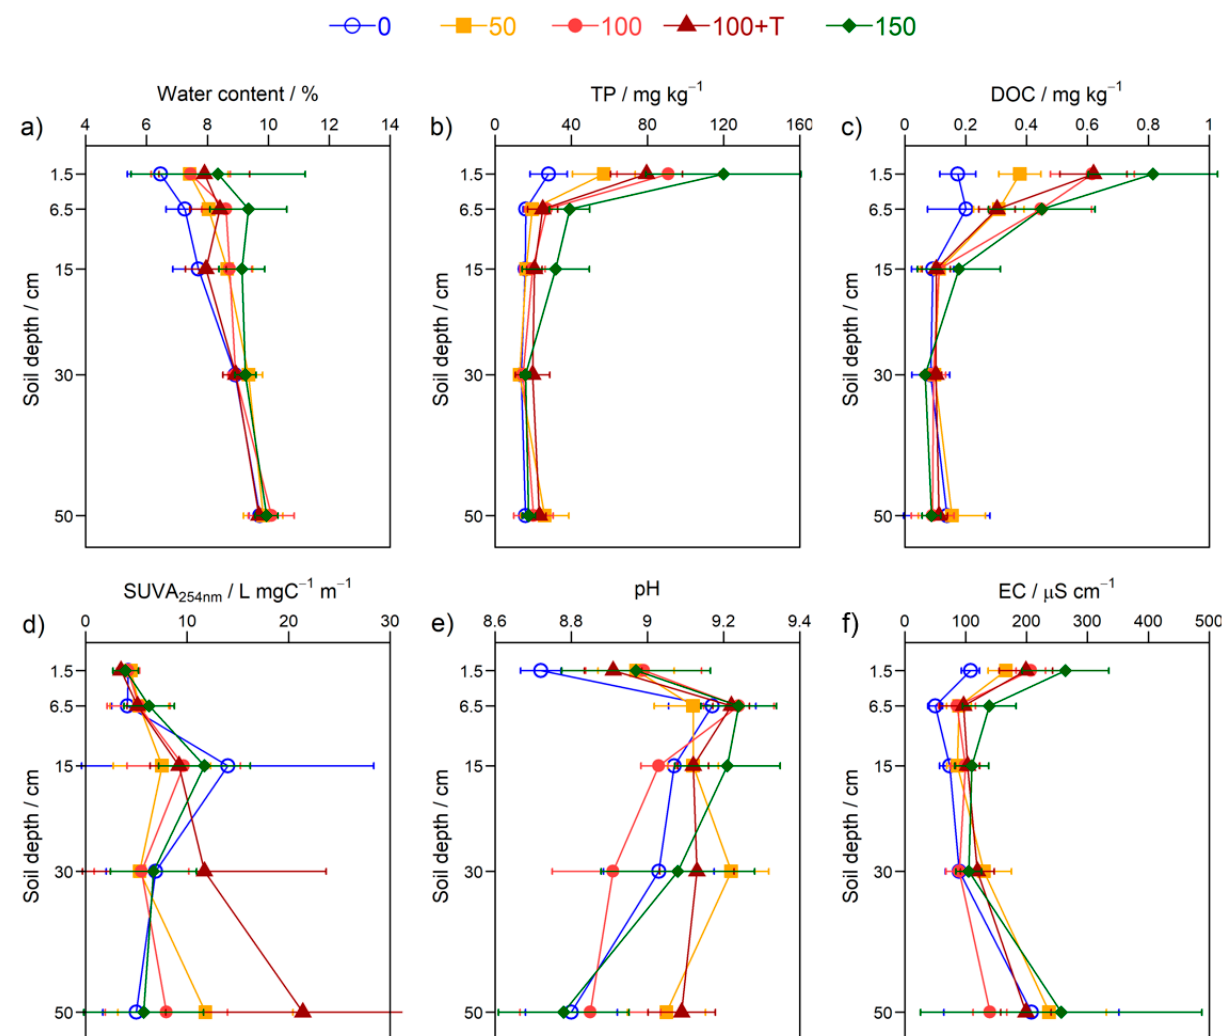
Figure 3. Depth soil profiles of ( a ) water content; ( b ) Total Phenols (TP); ( c ) dissolved organic carbon (DOC) ( d ) specific UV absorbance (SUVA); ( e ) pH; ( f ) electrical conductivity (EC) of the detailed survey before the third application of OMW. OMW application rates are 0 (control), 50, 100, and 150 m 3 ha − 1 y − 1 and 100 m 3 ha − 1 y − 1 followed by shallow tillage (100 + T).